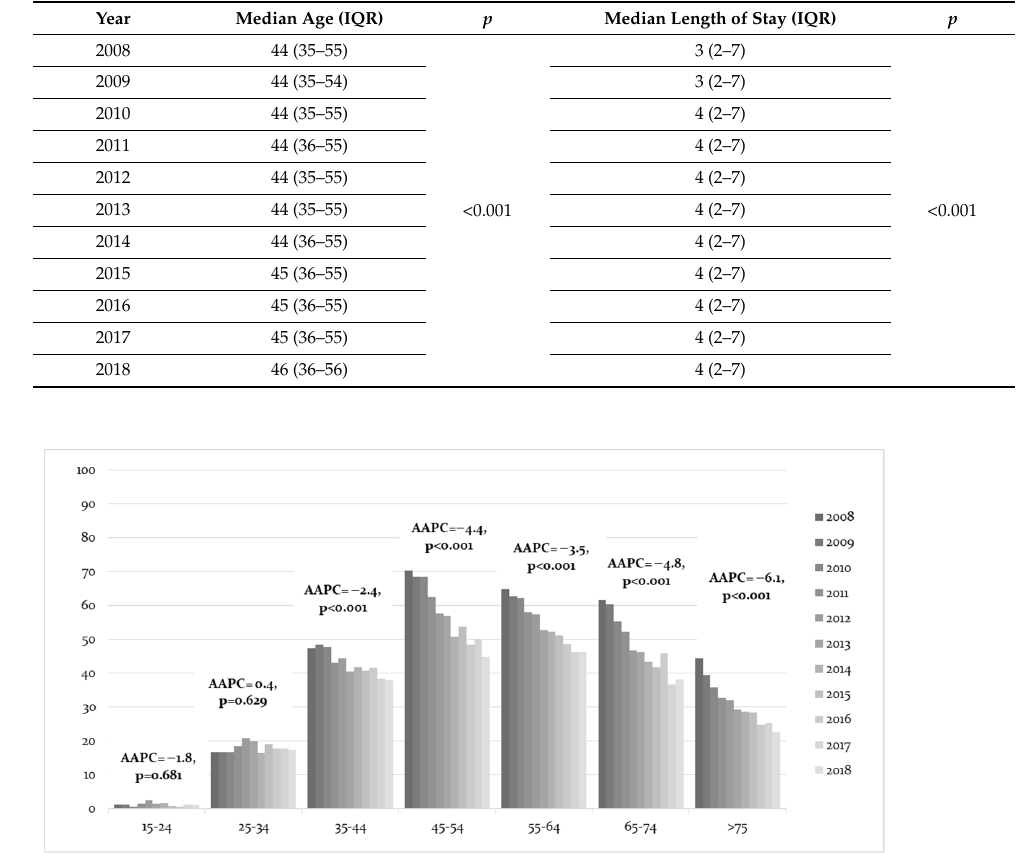
Figure 2. Average annual percent change (AAPC) of invasive cervical cancer trends in women’s classes of age and year regarding hospital admission, with related confidence intervals at 95%.